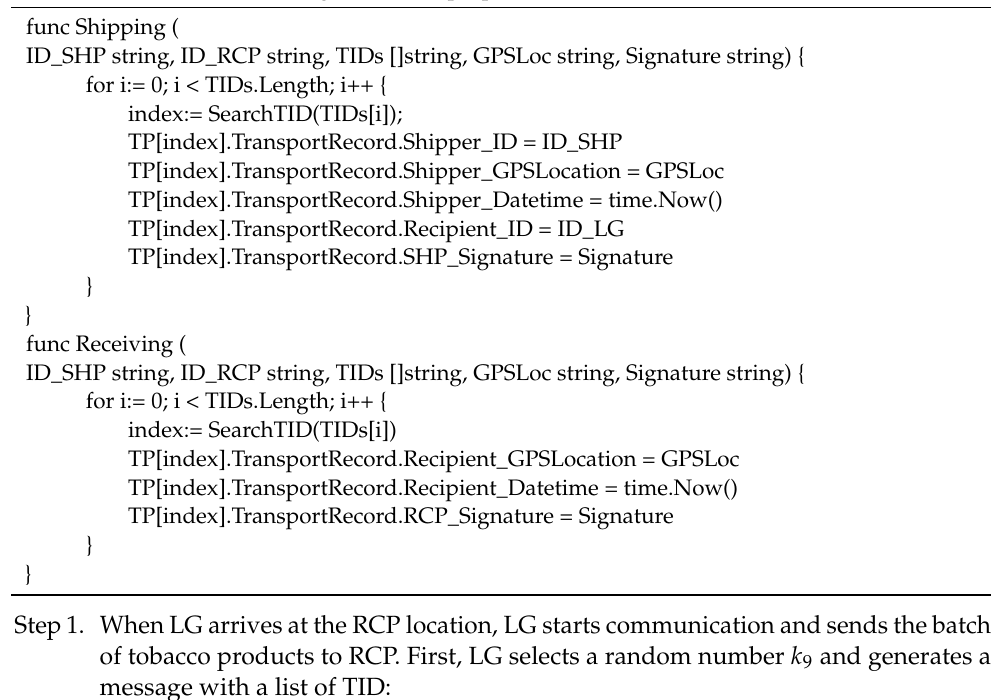
Algorithm 4. Chaincode of logistics of the proposed